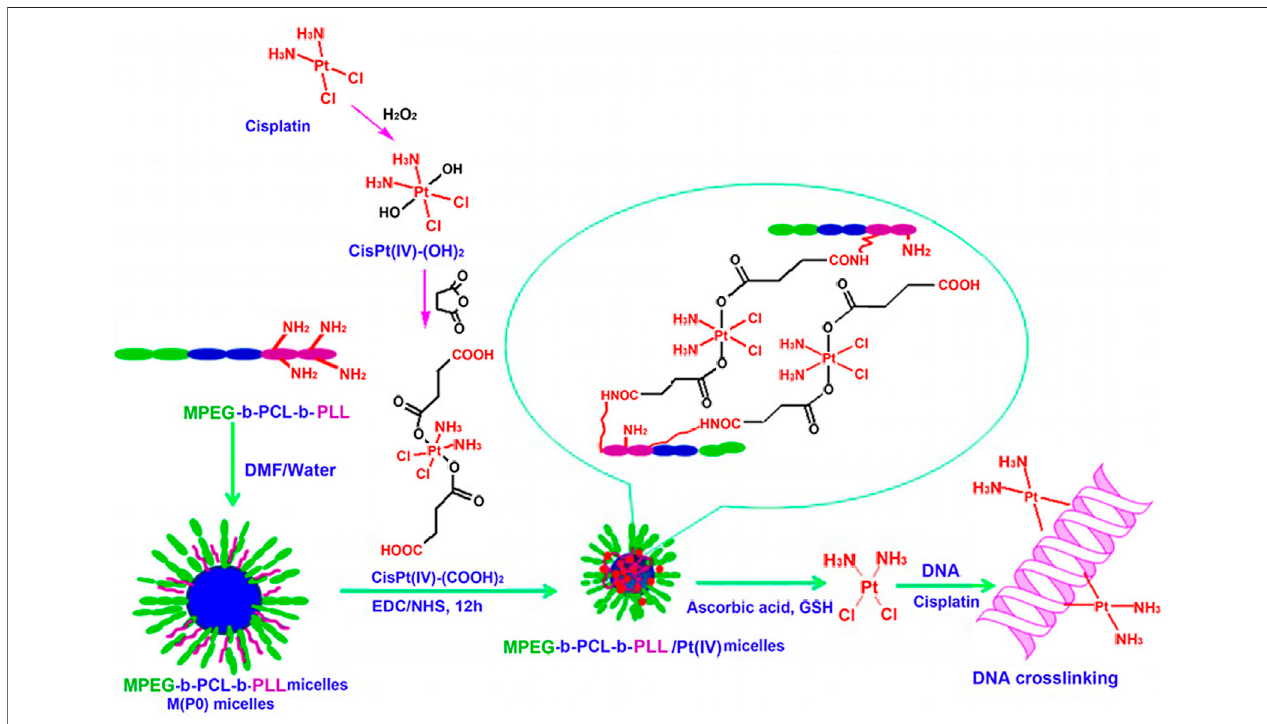
FIGURE 7 | Preparation of MPEG-b-PCL-b-PLL/cisPt (IV) micelles and the proposed pathway of action (Song et al., 2013). Abbreviation: PLys, poly(L-lysine); PLLA, poly(L-lactide); PIC, polyion complex.